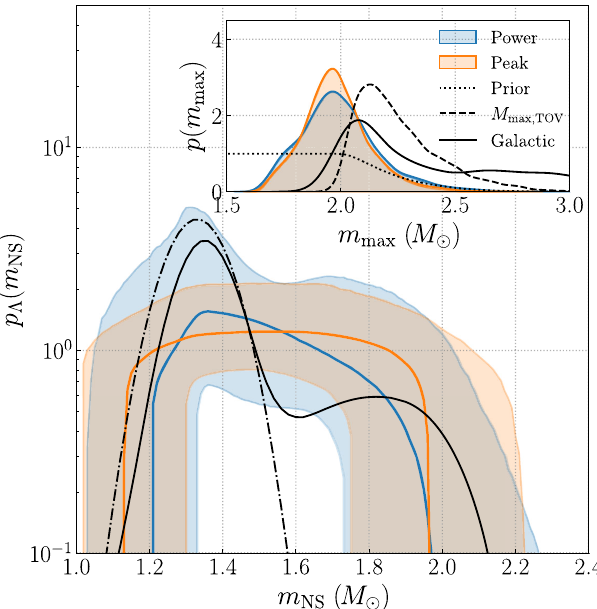
FIG. 7. Inferred neutron star mass distribution. The median mass distribution (solid) and 90% credible interval (shading) inferred for the P OWER (respectively, P EAK ) population model is shown in blue (orange), as compared to the mass distribution of NSs in Galactic BNSs [92] (dot-dashed black) and the mass distribution of all Galactic NSs [192] (solid black). The inferred gravitational-wave population has a greater prevalence of high- mass NSs, although the Galactic population of NSs extends to masses above those detected in gravitational waves thus far. The inset shows the posterior distribution for the maximum mass in the NS population for both models, as compared to the Galactic m . The EOS-informed m prior, which is proportional to the max max cumulative distribution function of M , is also shown in the max ; TOV using the maximum inset (dashed). It enforces m ≤ M max ; TOV Tolman-Oppenheimer-Volkoff mass estimate from Ref. [25]. The maximum mass in the gravitational-wave population is as large as M within statistical max ; TOV